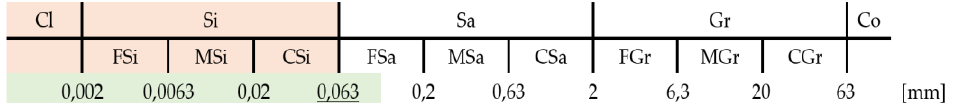
Figure 1. Schematic division of soil fractions (adapted from Ref. [43]). Orange and green colors indicate the key range of silt fraction f Si and clay fraction f Cl in this article together with the limiting grain size diameters.